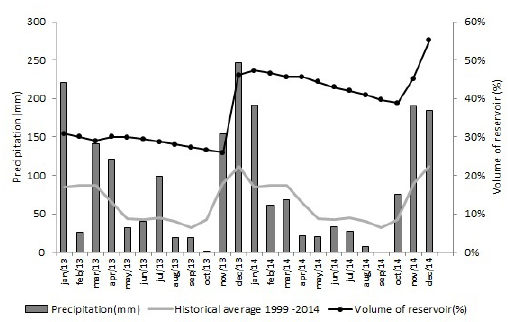
Figure 2. Cumulative rainfall in Jequié city, and volume in Barragem da Pedra reservoir between 2013 and 2014 years, and historical average precipitation. Source: Precipitation - Agritempo; Volume of reservoir – Agência Nacional de Águas (ANA, 2016).